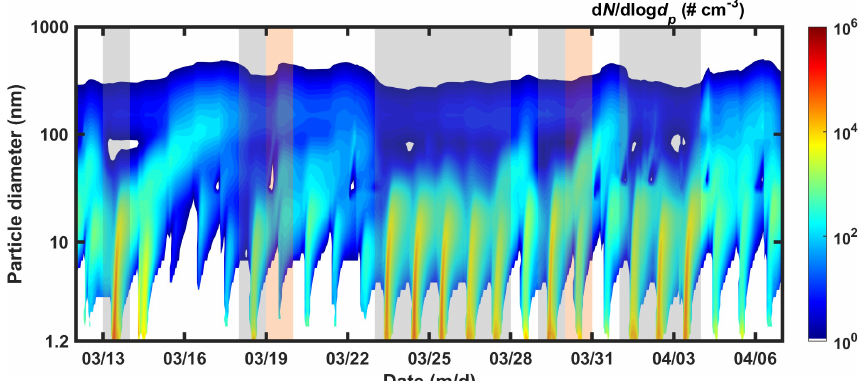
Figure 8. The simulated particle size distributions based on the TIMN scheme. The identified NPF days and undefined days are shaded with a grey and orange background, respectively.